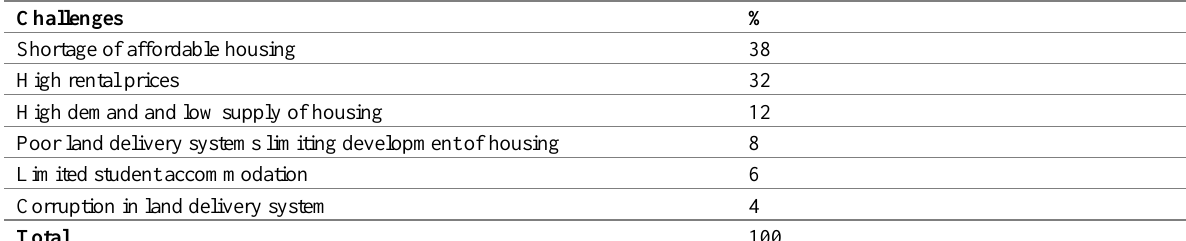
Table 1: Challenges faced by the residents as a result of urbanization on